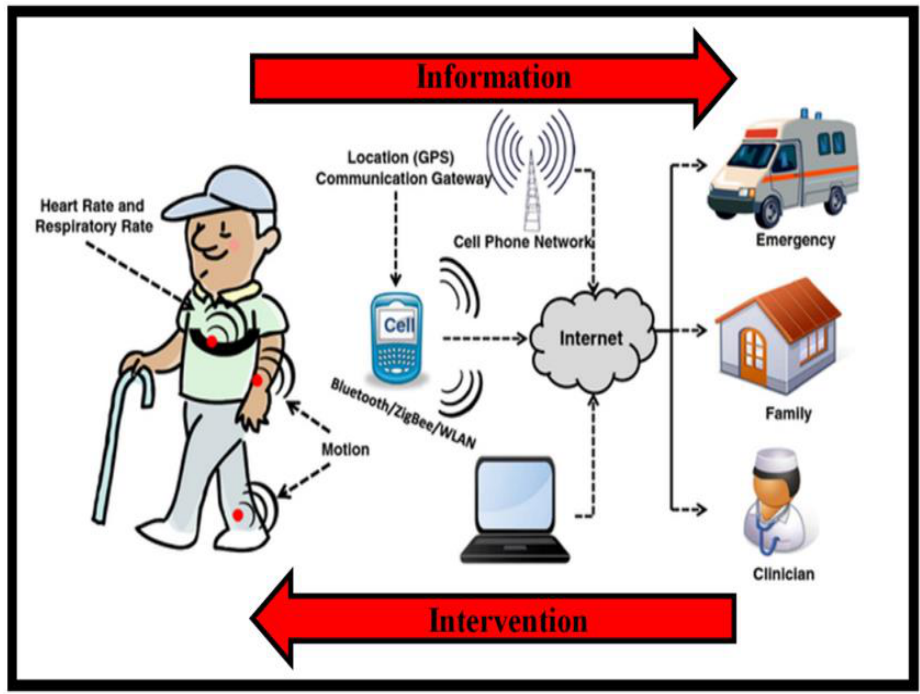
Figure 2. A conceptual picture of a remote surveillance system [45].